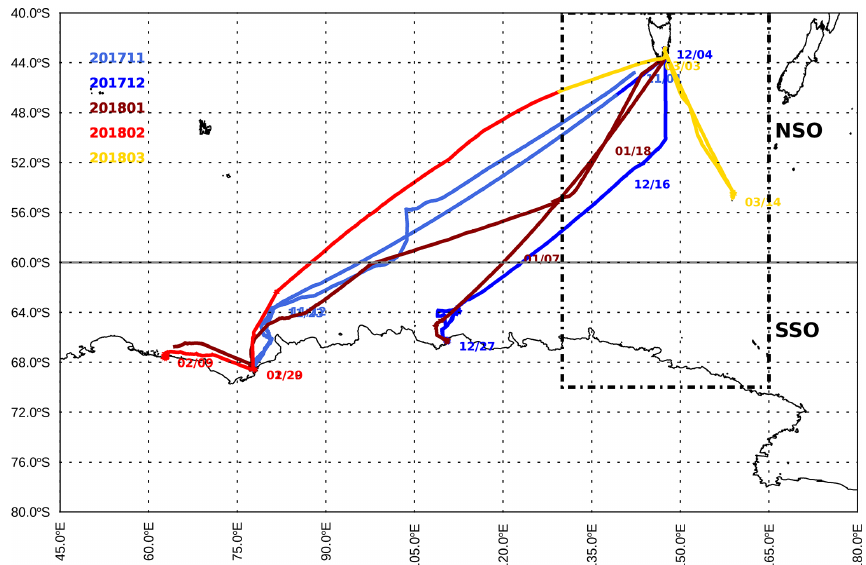
Figure 1. Ship track measurements between Hobart, Australia, and Antarctica. Different colors represent a different month’s ship tracks, from 29 October 2017 to 23 March 2018, during MARCUS. Along the ship tracks, the study domain is separated into northern (NSO) and southern (SSO) parts of the Southern Ocean, with a demarcation line of 60 ◦ S in order to study the clouds over the midlatitudes (north of 60 ◦ S) and polar region (south of 60 ◦ S). The black dotted rectangle represents the SOCRATES study domain. Some of the dates are labeled along the ship tracks, indicating the direction of the